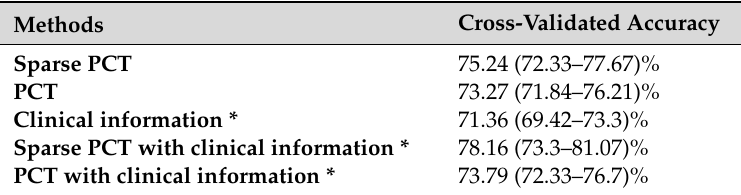
Table 2. The results of random forest classification for the cross-validated